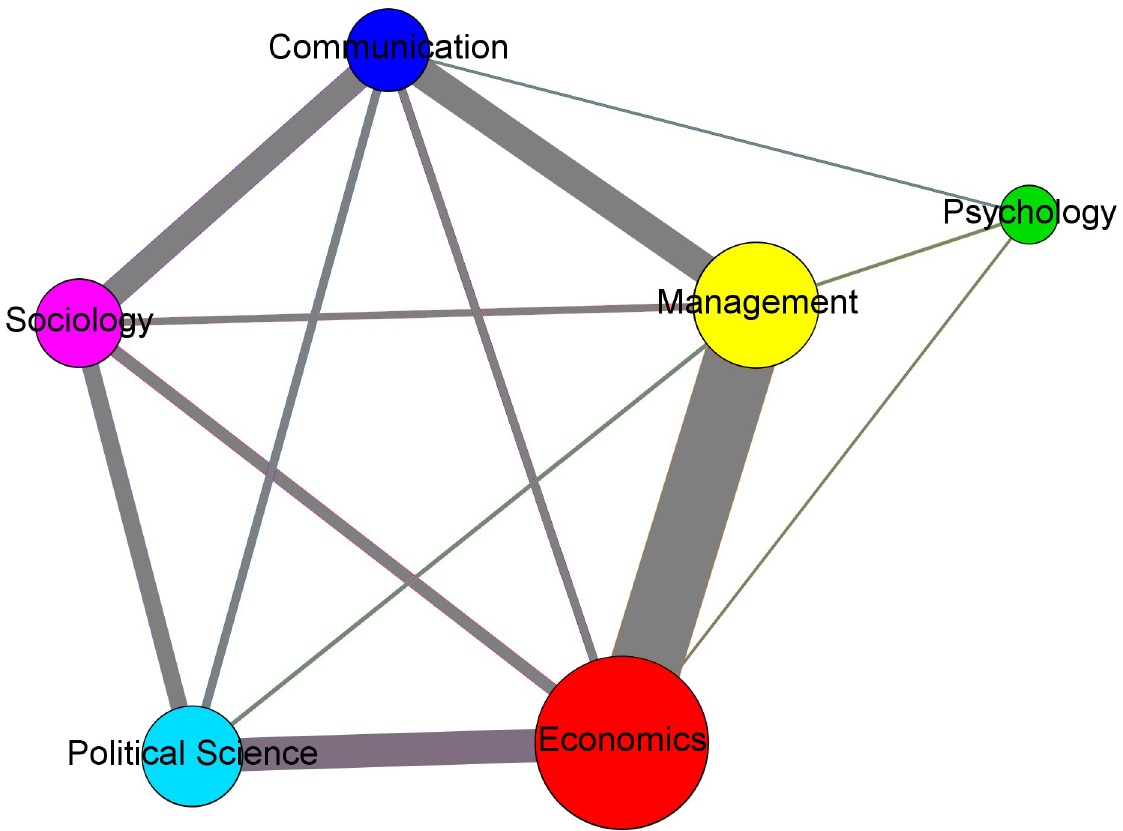
Fig 4. Connections between fields. Size of fields is proportional to the number of journals in the main component. Thickness of connections is proportional to the number of shared EBs. https://doi.org/10.1371/journal.pone.0273552.g004 as members of EBs. Economics has the most unbalanced gender distribution, with only 20% of female scholars. When it comes to network metrics, Kruskal-Wallis non-parametric tests show that there is no difference for degree (H = 1.00, p = 0.318) or betweenness centrality (H = 1.04,